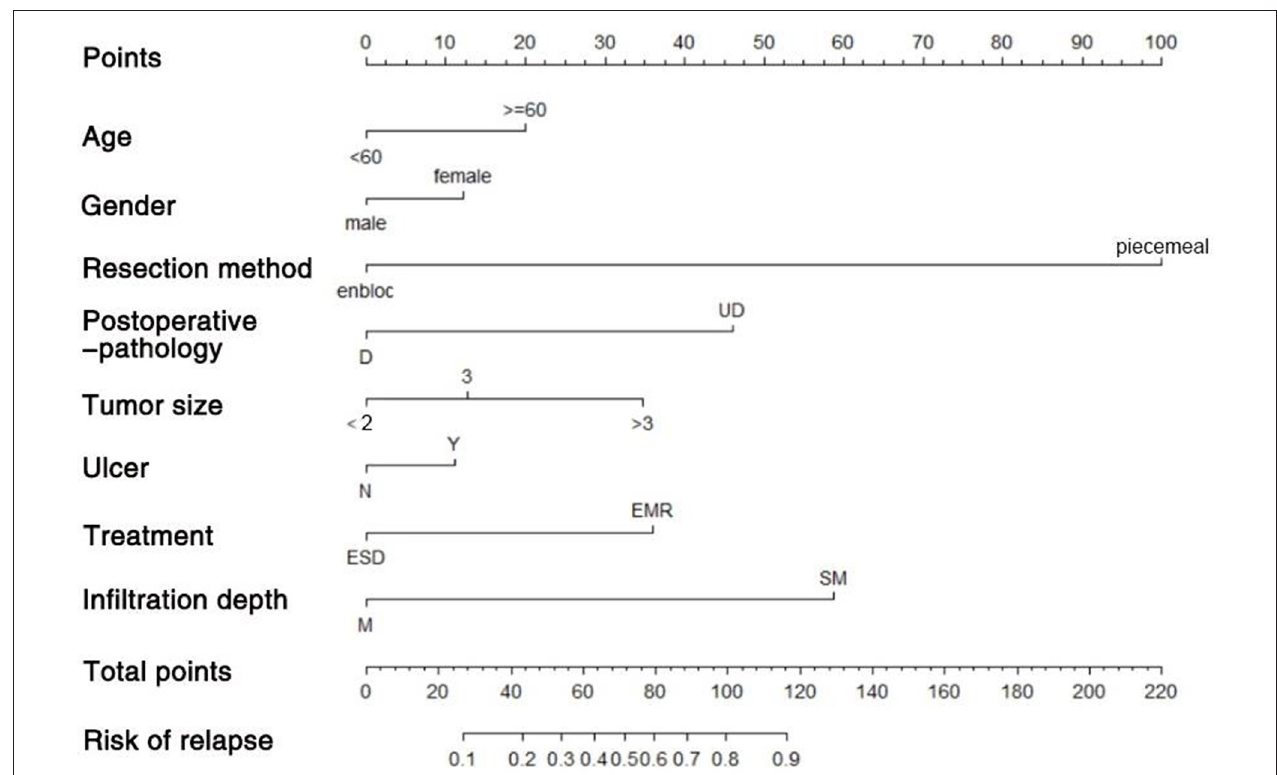
FIGURE 2 | Predictive nomogram for the EGCs undertaking ESD/EMR potential to develop non-curative resection.